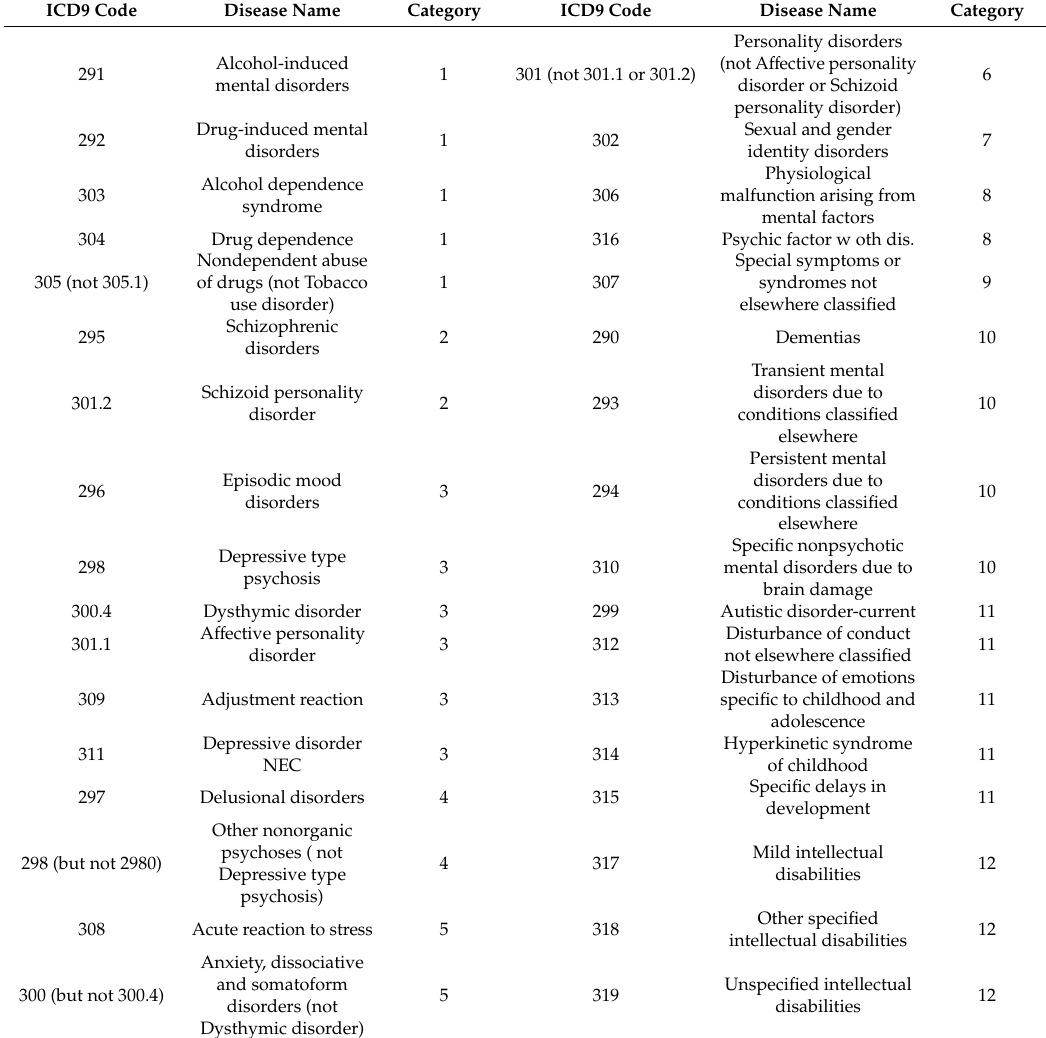
Table A2. Categories of Comorbid Diseases.